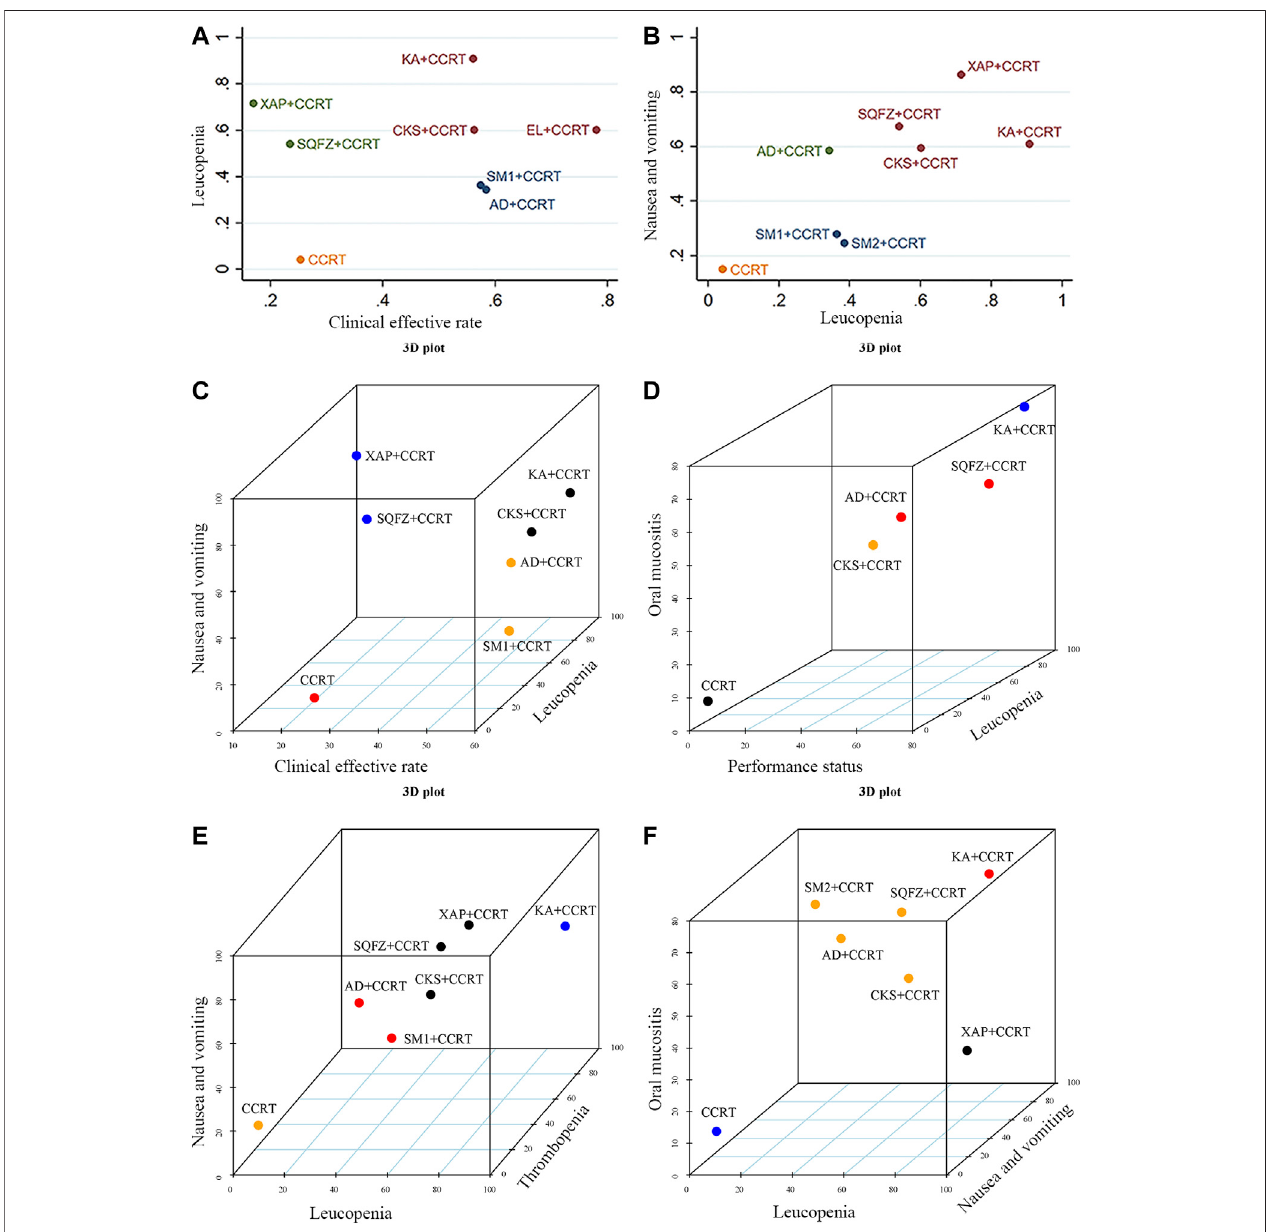
FIGURE 5 | Cluster analysis plots for six outcomes. (A) Clinical effective rate ( x -axis) and leukopenia ( y -axis), (B) leukopenia and nausea and vomiting ( y -axis), (C) clinical effective rate ( x -axis), nausea and vomiting ( y -axis), and leukopenia ( z -axis), (D) performance status ( x -axis), oral mucositis ( y -axis), and leukopenia ( z -axis), (E) leukopenia ( x -axis), nausea and vomiting ( y -axis), and thrombopenia ( z -axis), (F) leukopenia ( x -axis), oral mucositis ( y -axis), and nausea and vomiting ( z -axis). Note: (AD, Aidi injection; CCRT, concurrent chemoradiotherapy; CKS, Compound Kushen injection; EL, Elemene injection; KA, Kangai injection; KLT, Kanglaite injection; SM1, Shengmai injection; SQFZ, Shenqifuzheng injection; SM2, Shenmai injection; and XAP, Xiaoaiping